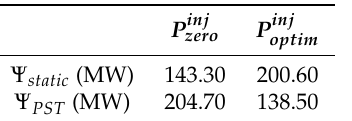
Table 6. Error values for the power flows comparison between the full and reduced model, without an explicit PST modeling.